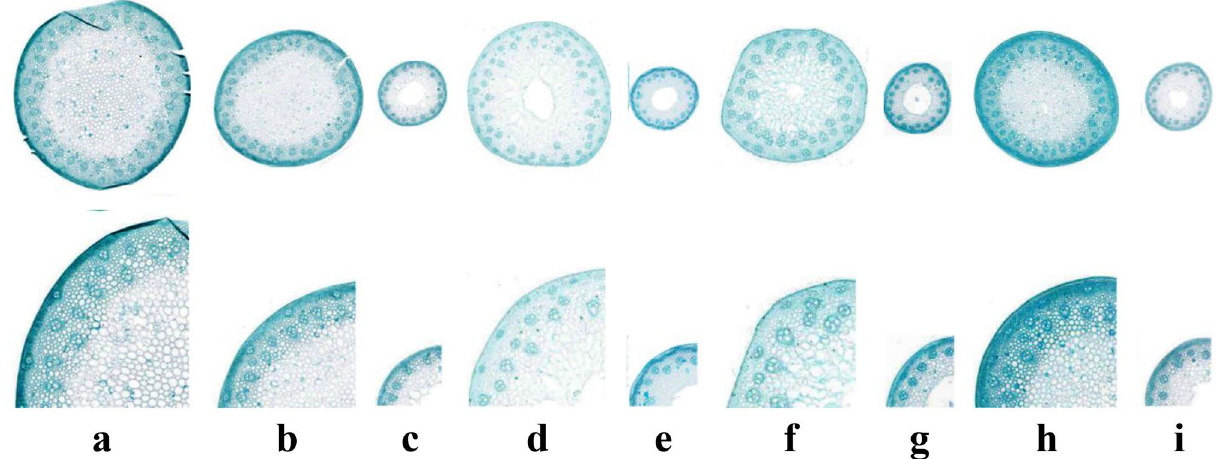
Figure 6. Anatomical structure of the second internode of synthetic hexaploid wheat and its parents in the field. ( a ): Ma; ( b ): Syn-SAU-116; ( c ): AS78; ( d ): Syn-SAU-117; ( e ): AS92; ( f ): Syn-SAU-118; ( g ): AS95; ( h ): Syn- SAU-119; ( i ): AS96.